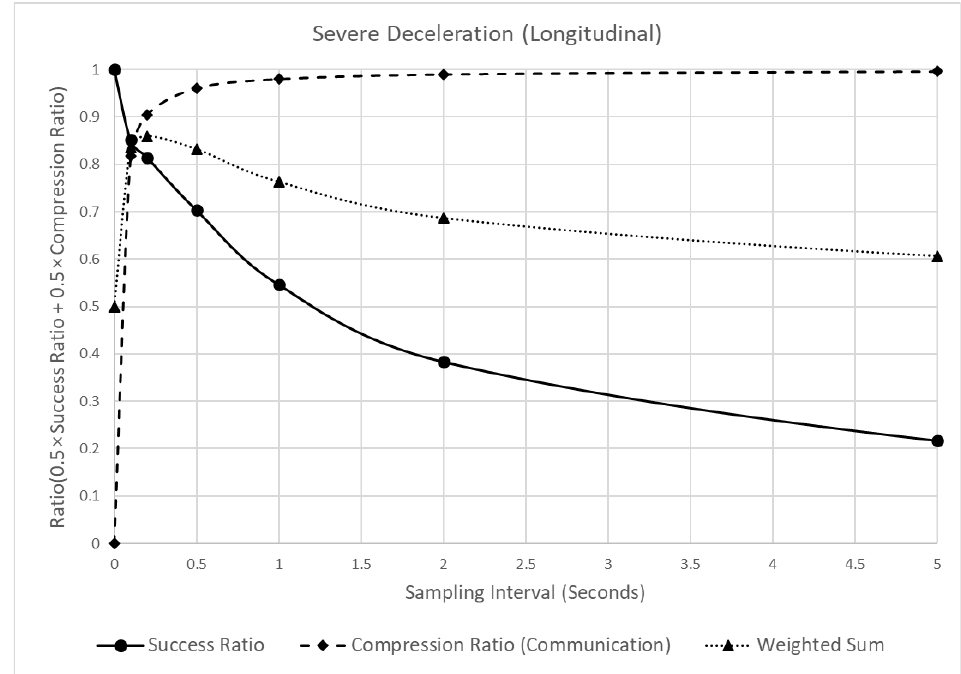
Figure 10. Analysis of the detection success ratio, compression ratio, and a weighted sum of the SD, varying the sampling interval.